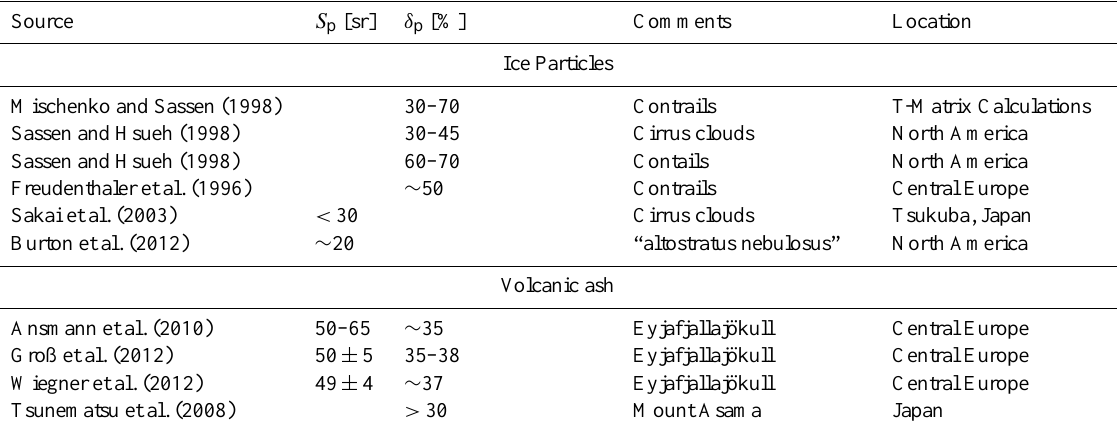
Table 8. Summary of the key findings concerning the lidar ratio ( S p ) and the particle linear depolarization ratio ( δ p ) found for ice particles and pure volcanic ash